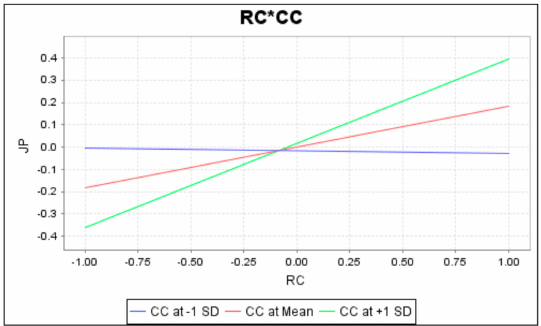
Figure 5. Moderation of career calling on the relationship between role conflict and job